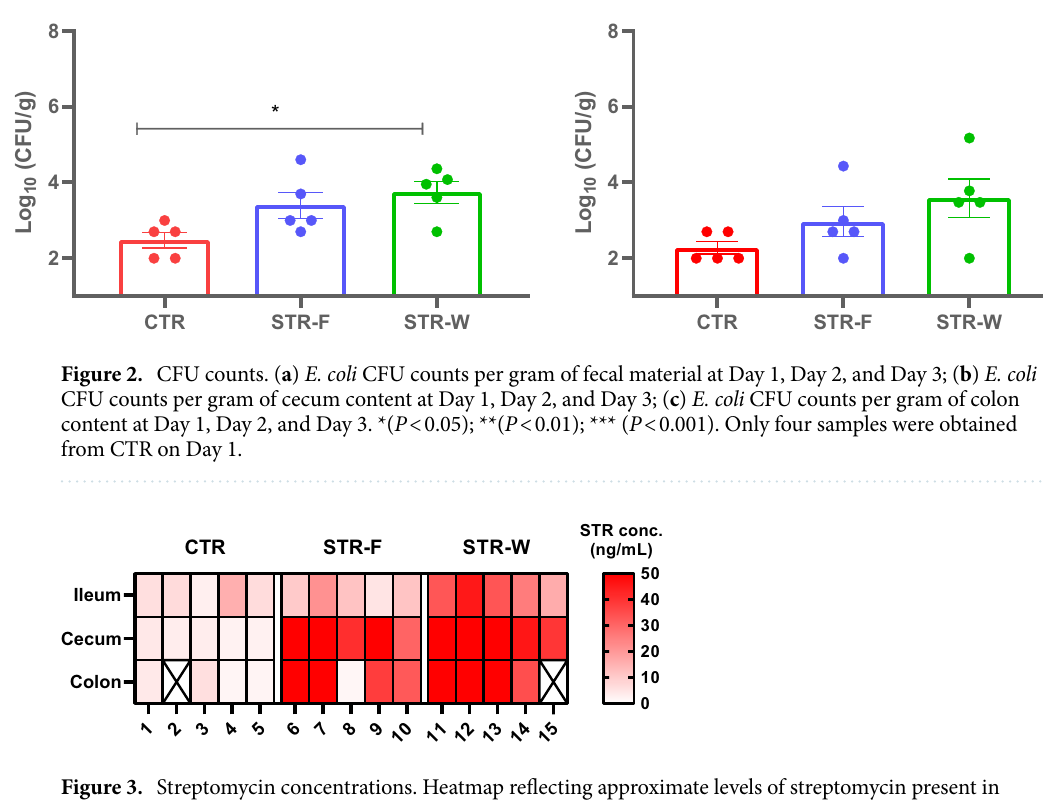
Figure 3. Streptomycin concentrations. Heatmap reflecting approximate levels of streptomycin present in ileum, cecum and colon STR-W and STR-F levels are different in ileal samples (P < 0.005), while levels in cecum and colon do not differ between the two groups. The assay was saturated above 50 ng/mL. Figure was made in GraphPas Prism as described in the methods